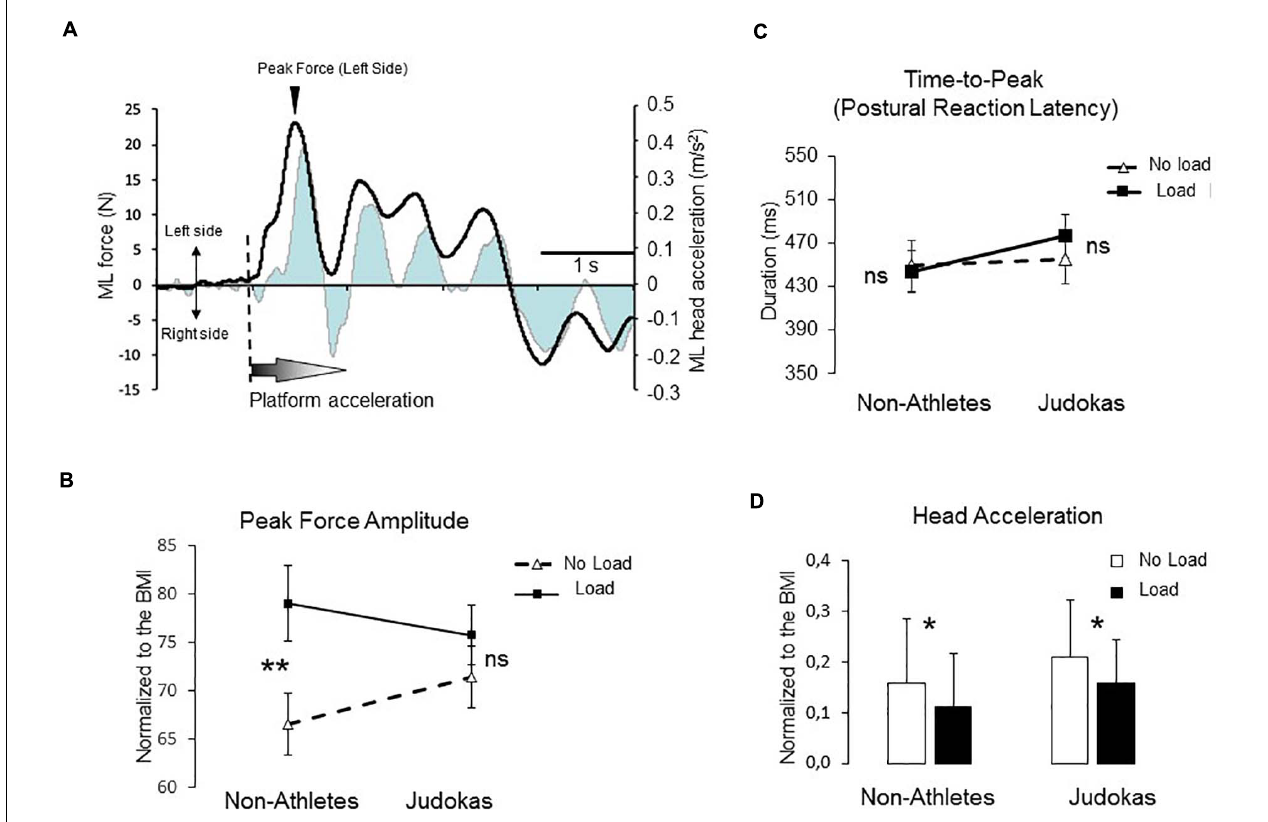
FIGURE 4 | (A) The illustration represents the mean mediolateral force (black line) superimposed on the lateral head acceleration (gray line) for one participant. (B) Amplitude of the peak force for Non-Athletes and Judokas (error bars are standard error of the mean) (** p < 0.005 and ns: not significant) (C) Duration between the onset of the translation and the force peak (i.e., postural reaction latency) in Non-Athletes and Judokas (error bars are standard error of the mean) (ns: not significant) (D) Integrals of head acceleration during a 2-s period for Non-Athletes and Judokas normalized to the BMI (* p <